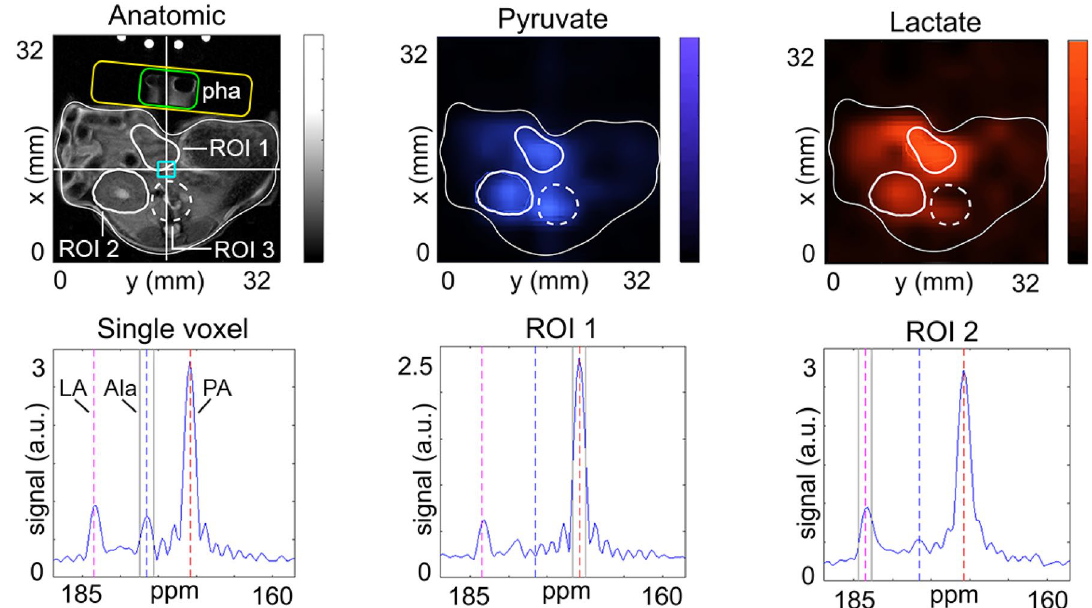
Figure 8. In vivo T1w 1 H-MRI, maps of hyperpolarized 1- 13 C-PA and 1- 13 C-lactate (LA) and selected 13 C spectra of a pancreatic tumor rat model acquired at 7 T. After the injection of 100 µl hyperpolarized contrast agent containing ~ 46 mM 1- 13 C-PA, eight CSI datasets were acquired. Prominent signal of lactate was found in the regions of kidney (ROI1), liver (ROI2), aorta and inferior vena cava branch (ROI3). Strong SNR was observed in the selected voxel (blue rectangle), exhibiting resonances of lactate, pyruvate and alanine (Ala) with a line width of ca. 84 Hz. The receive-only loop-coil was positioned ventral (yellow rectangle) and a small container filled with water was placed in the middle of the coil (green rectangle, phantom—Pha). Note